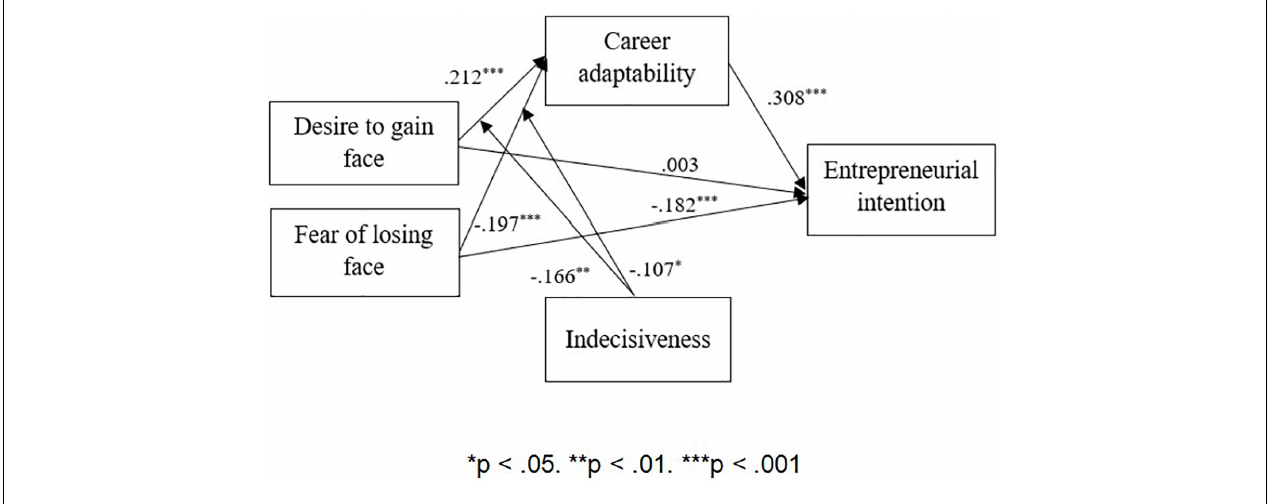
FIGURE 4 | Summary of the regression